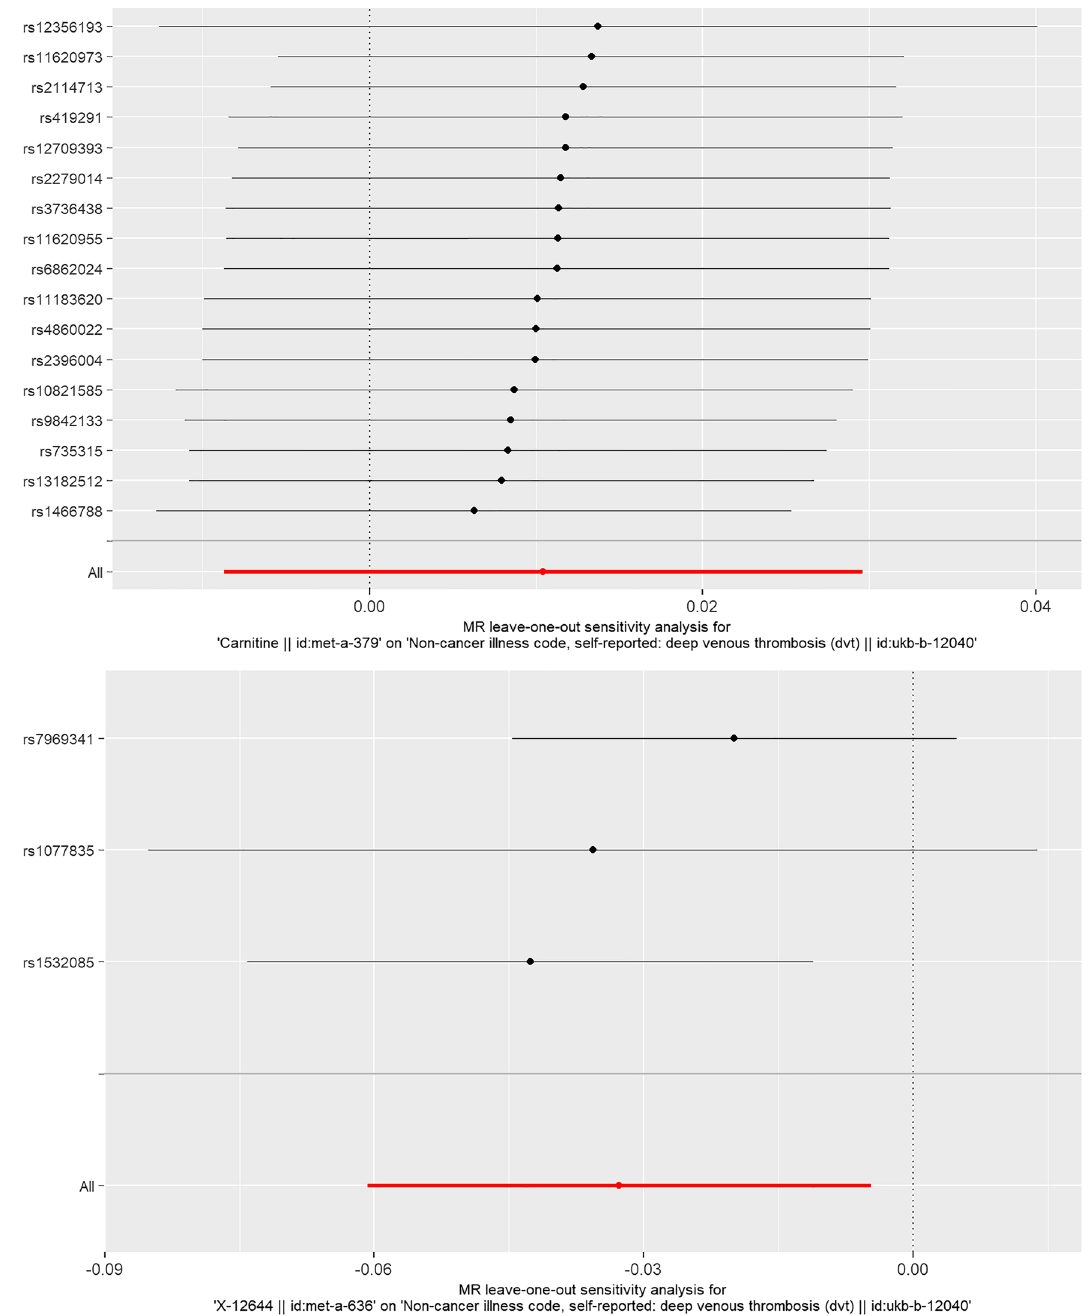
Figure 4. Sensitivity analysis of the MR results (Carnitine, X-12644). As the other 7 blood metabolites were included in fewer instruments, the Leave-one-out test could not be used to test